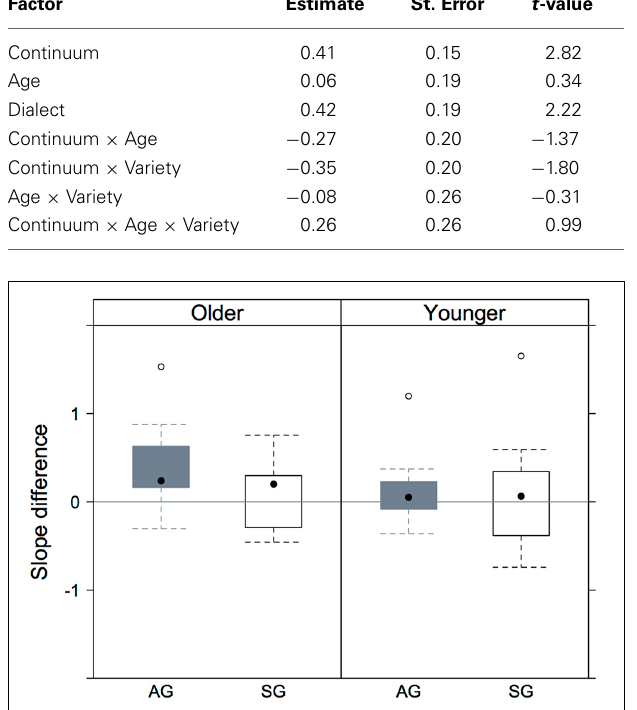
(cid:2) (cid:2) FIGURE 6 | The distributions resulting from subtracting the slopes of ]t from those of the vermi[s/ ]e continua separately per the mi[s/ listener. There is one point per listener in each distribution. The rectangle spans the inter-quartile range; the black dot in the center of the rectangle is (cid:2) (cid:2) the distribution’s median. Values above the horizontal zero line denote a ]e than in mi[s/ larger slope in vermi[s/